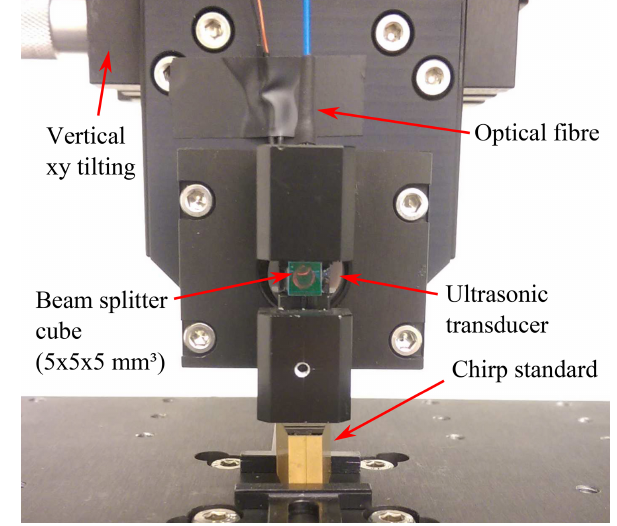
Figure 3. Fibre-coupled interferometric–confocal high-speed dis- tance sensor using a 1550nm laser source.